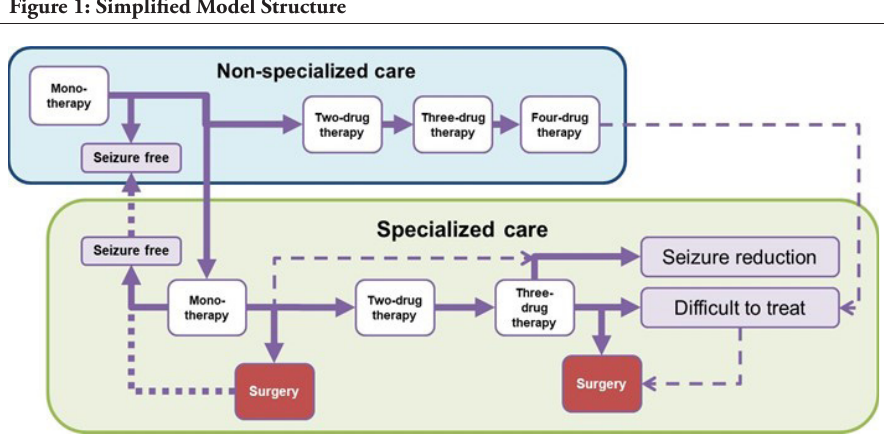
Figure 1: Simplified Model